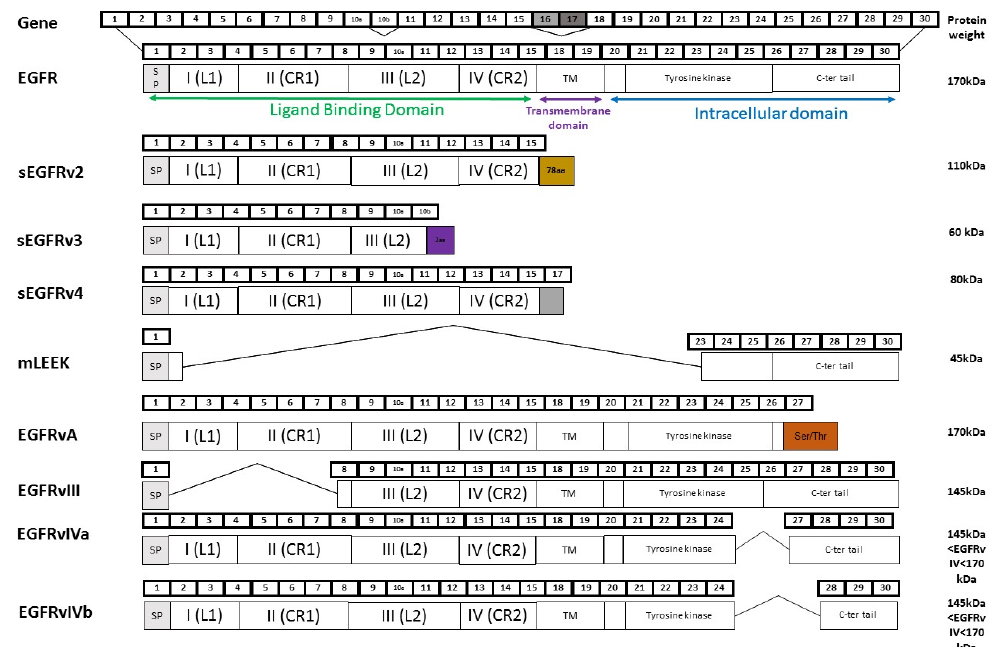
Figure 2. EGFR and its splicing variants. Alternative splicing of EGFR generates eight variants including those that encode soluble isoforms, sEGFRv2, sEGFRv3, and sEGFRv4, and those can encode non-soluble isoforms, mLEEK, EGFRvA, EGFRvIII, EGFRvIVa, and EGFRvIVb. For each splice variant, the number of exons (upper) and functional domains of the protein (lower) are represented. L: ligand binding, CR: Cysteine-Rich.